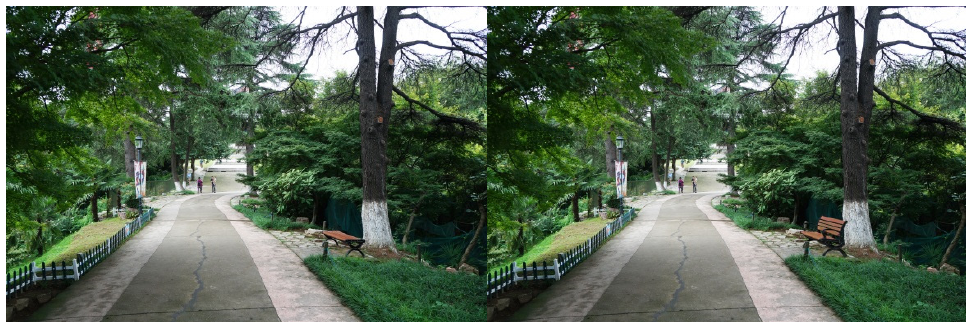
Figure 4. Example: Bench with backs and arms (a bench without backs or arms was replaced by a similar bench having both).